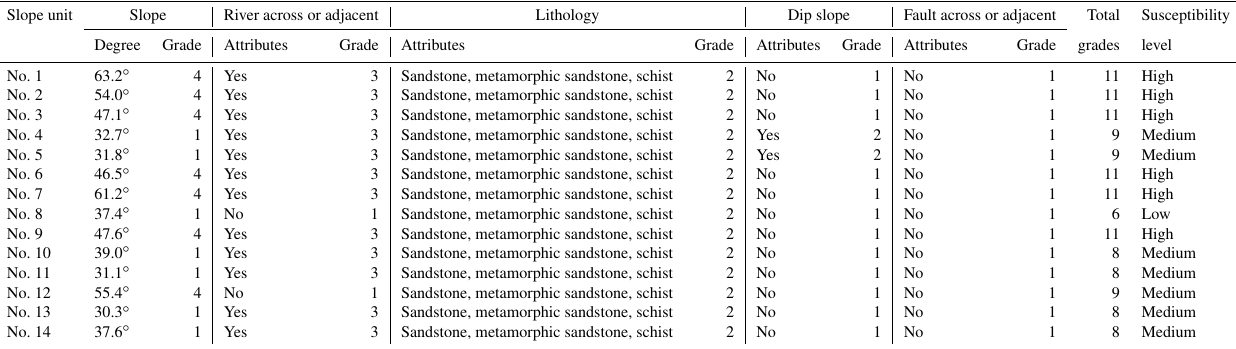
Table 12. Grades and levels of landslide susceptibility of slope units around the Neikuihui tribe. Slope unit